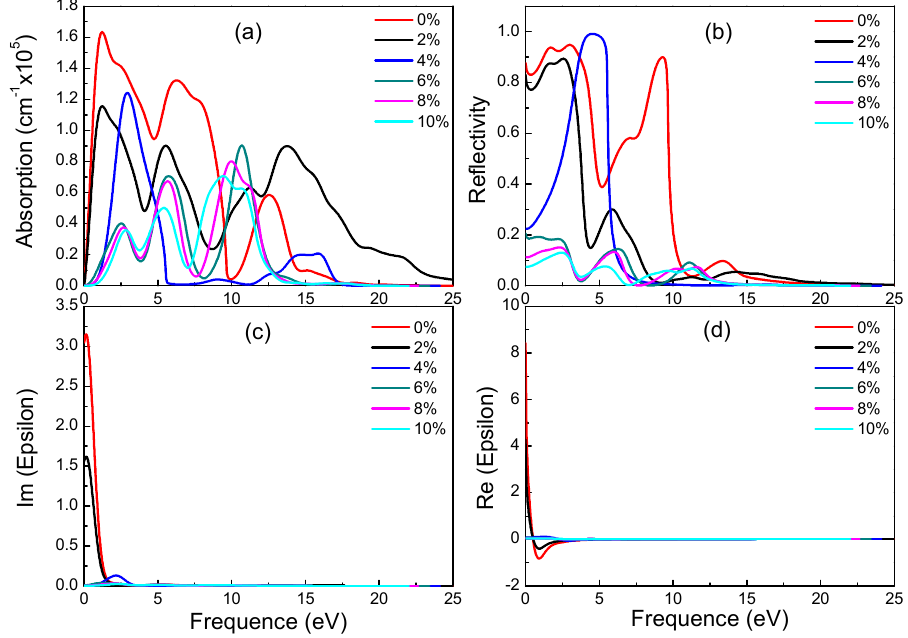
Figure 7. Absorption spectra ( a ), reflectivity ( b ), imaginary ( c ) and real ( d ) part of the dielectric constants of β -graphyne under different strains.